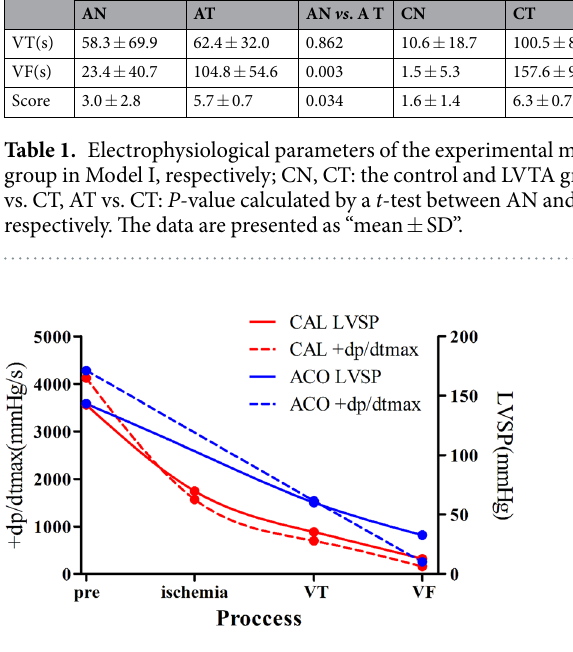
Figure 2. Change tendencies of left ventricular systolic pressures and + dp/dtmax values in LVTA models. The cardiac functions dramatically decreased in both LVTA models in particular after VT/VF, as illustrated by LVSP and + dP/dtmax data graphed in the figure. LVSP: left ventricular systolic pressure; + dP/dtmax: the maximum left ventricular pressure increase; pre: prior to aconitine injection or CAL operation; ischemia, VT and VF represent ligation time points in CAL operations and the onsets of VT and VF,